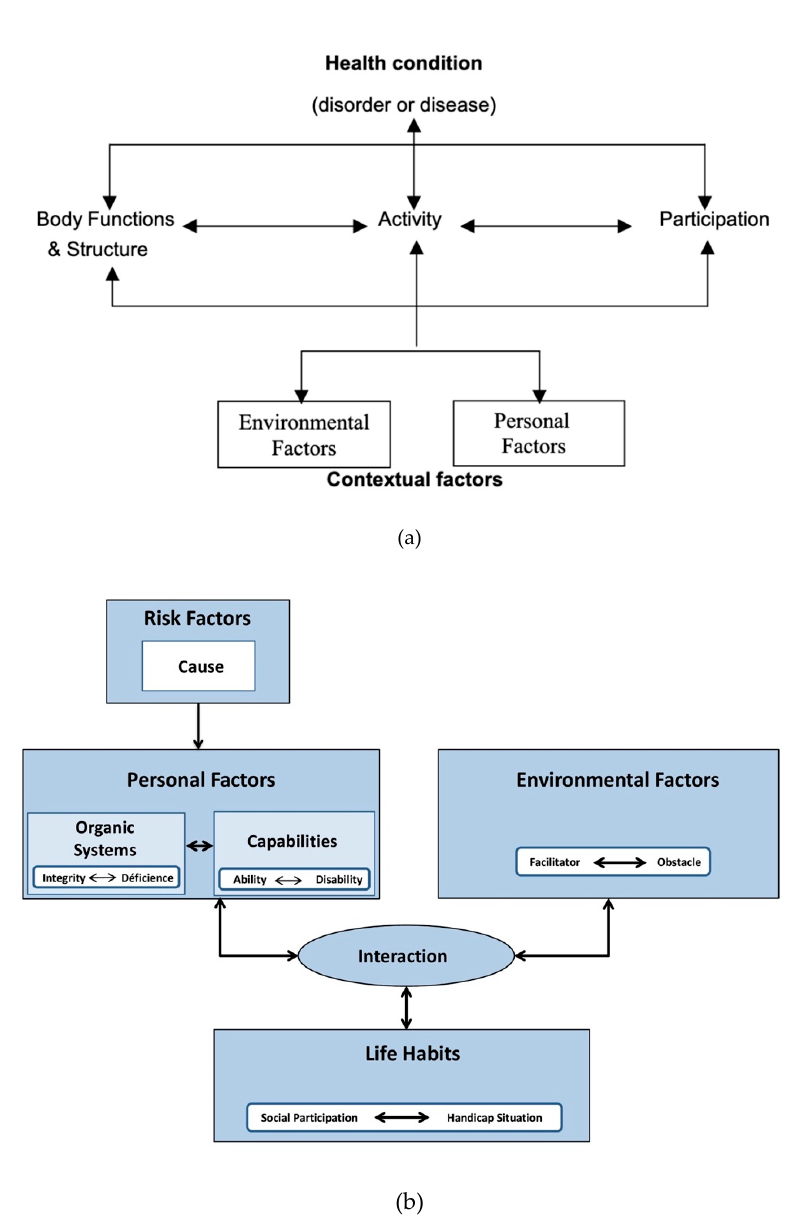
Figure 1. ( a ). The International Classification of Functioning, Disability and Health (ICF) model [14]. ( b ). Human Development Model—Disability Creation Process (HDM ‐ DCP) RIPPH 1998 [15].